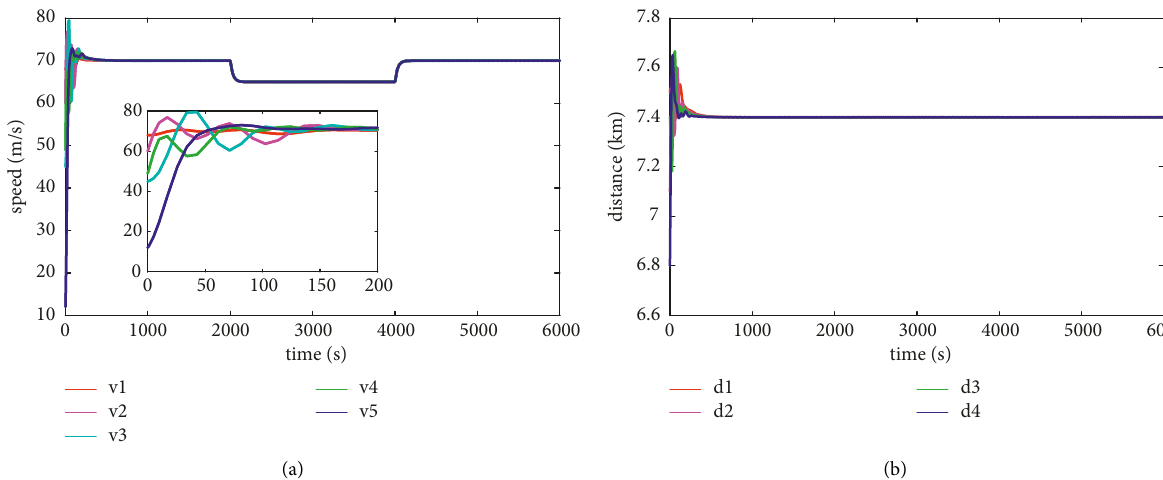
Figure 6: The simulation results of applying the cooperative control strategy in the study of [17], which keeps the distances in a constant distance. (a) The speed curves. (b) The distance between adjacent trains.